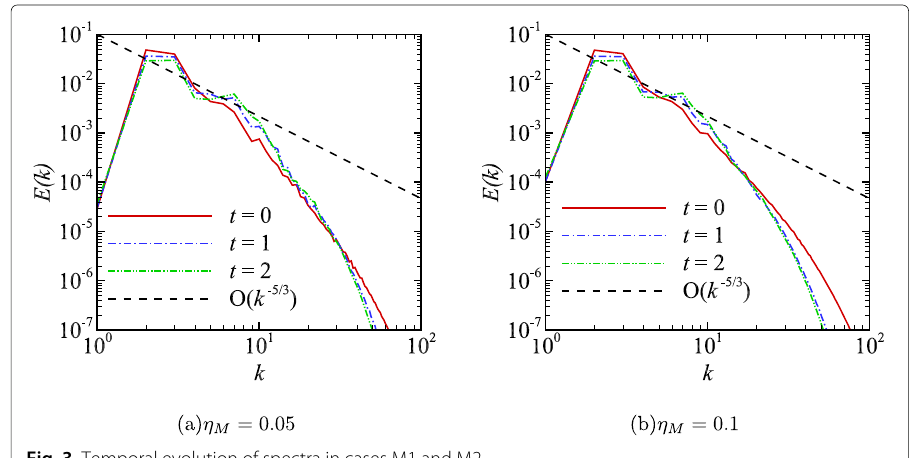
Fig. 3 Temporal evolution of spectra in cases M1 and M2